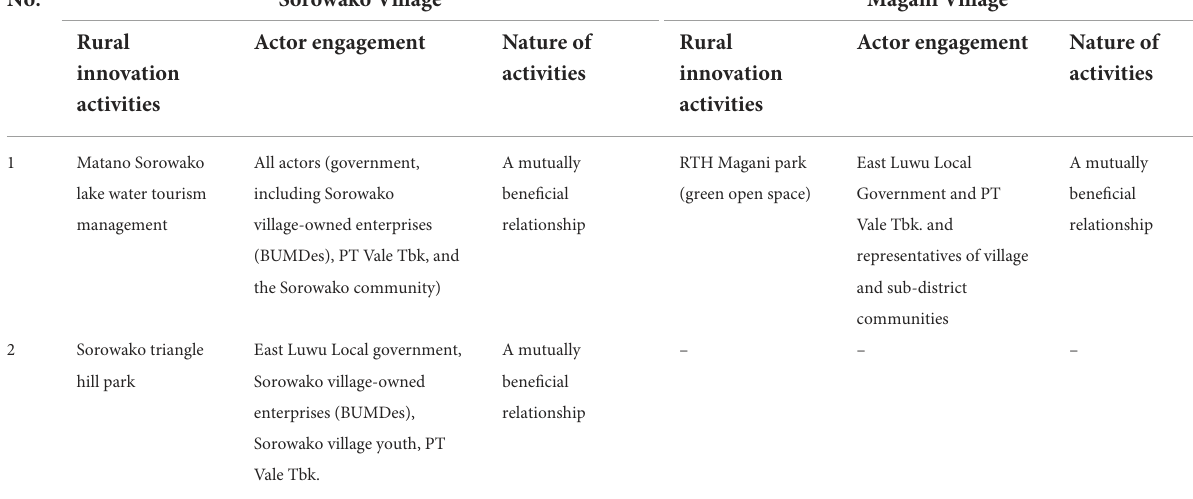
TABLE 2 Involvement of actors in rural innovation activities of Sorowako and Magani tourism villages in East Luwu Regency.